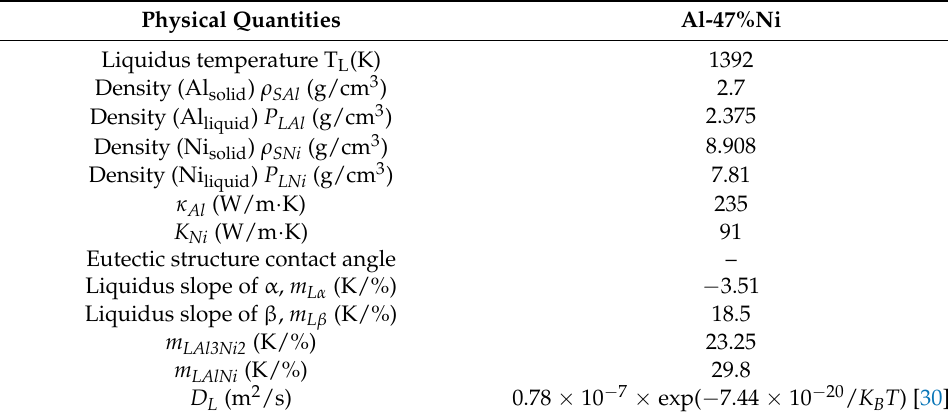
Table 2. The physical parameters used for calculation.